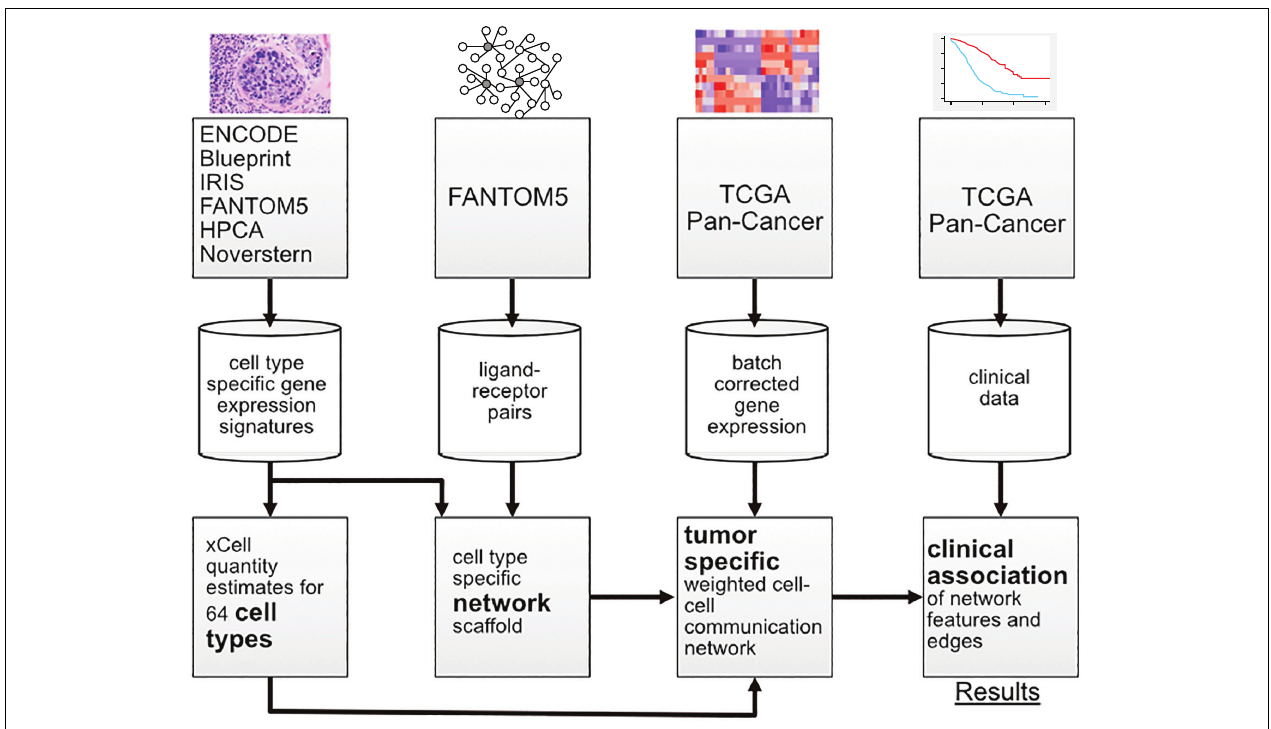
FIGURE 1 | Overview of the workflow showing the transition from data sources to